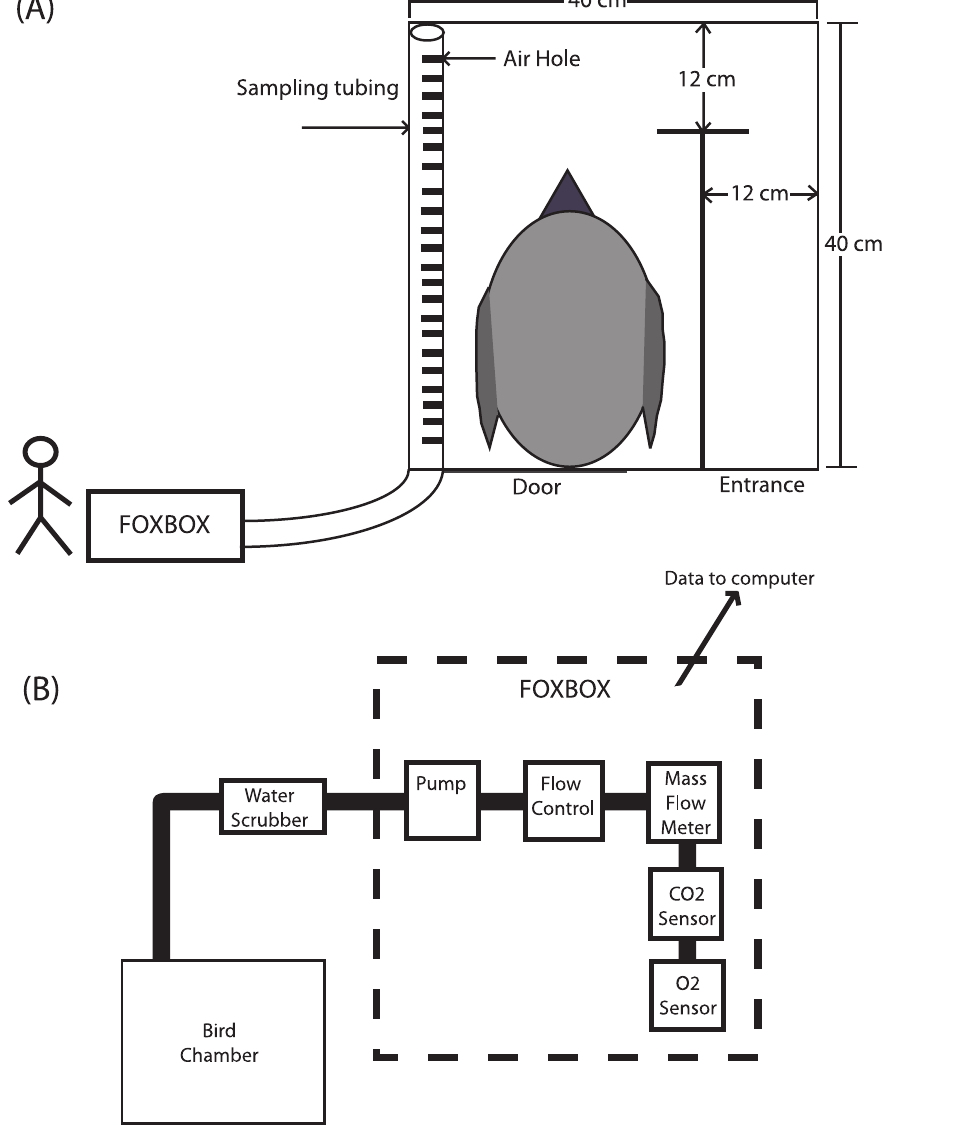
Figure 1. Schematic representation of a nest-box modified into a metabolic chamber (A) and airflow from a bird chamber to FOXBOX (B). Air pulled from a nest chamber into FOXBOX (A). Concentrations of CO 2 and O 2 inside a nest box were measured through FOXBOX (B).